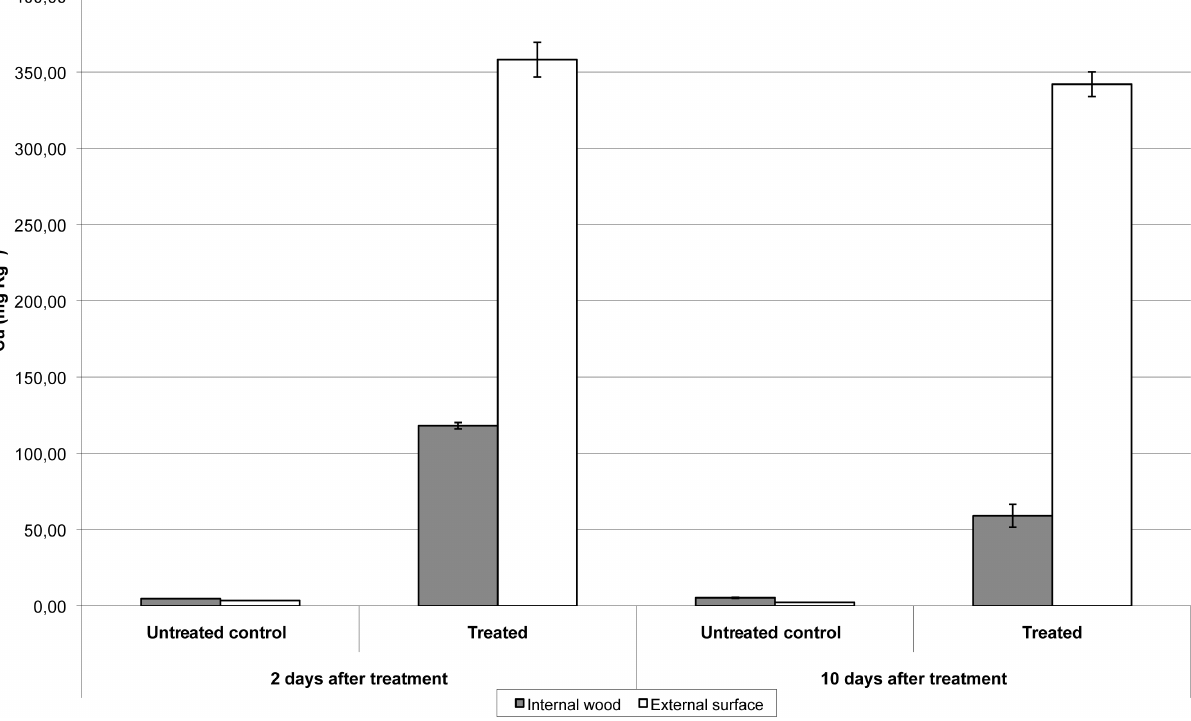
Figure 1. Amount (mg Cu kg -1 ) of copper sprays detected on the surface or in the wood of stems of potted vines 2 or 10 days after spraying. Copper in the wood samples was detected by inductively coupled plasma-optical emission